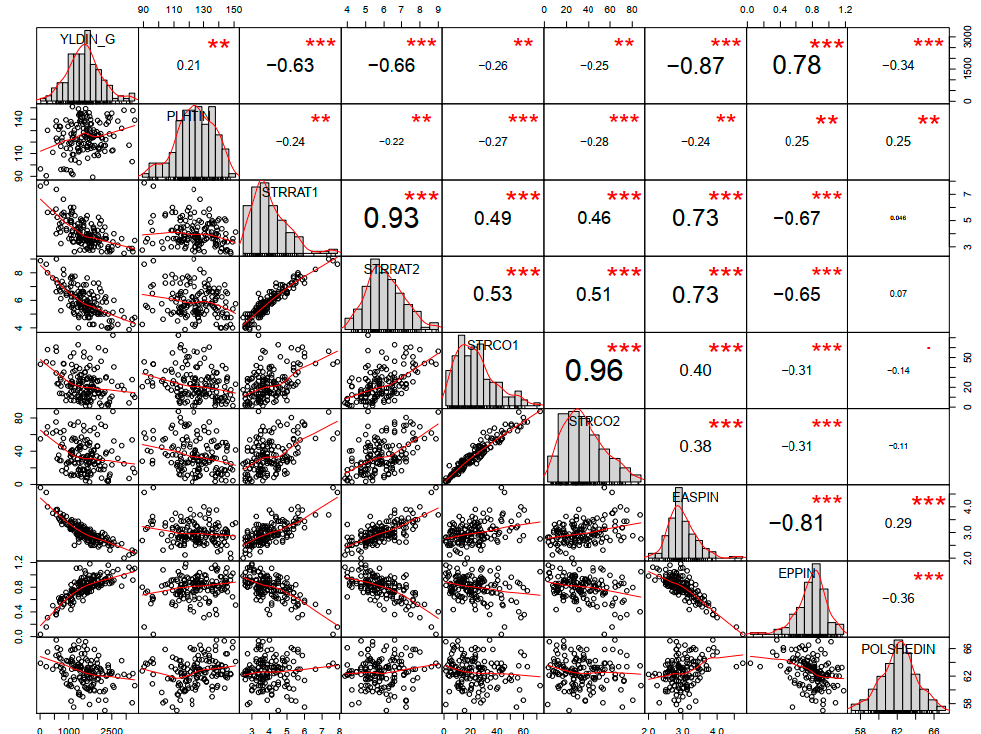
Figure 2. Correlation coefficient under Striga infested. Striga Damage Symptom Rating (STTRAT 1 and 2) = Striga damage rating at 8 and 10; Weeks After Planting (WAP), Striga Count or Emerged Striga plant (STRCO 1 and 2) = Striga count at 8 and 10 WAP, Plant Height Infested (PLHTIN), Ear Per Plant Infested (EPPIN), Ear Aspect Infested (EASPIN), Days to anthesis infested (POLSHEDIN), Grain Yield under Striga Infestation (YLDIN). *** p significant at 0.001, ** p significant at 0.01, * p significant at 0.05.